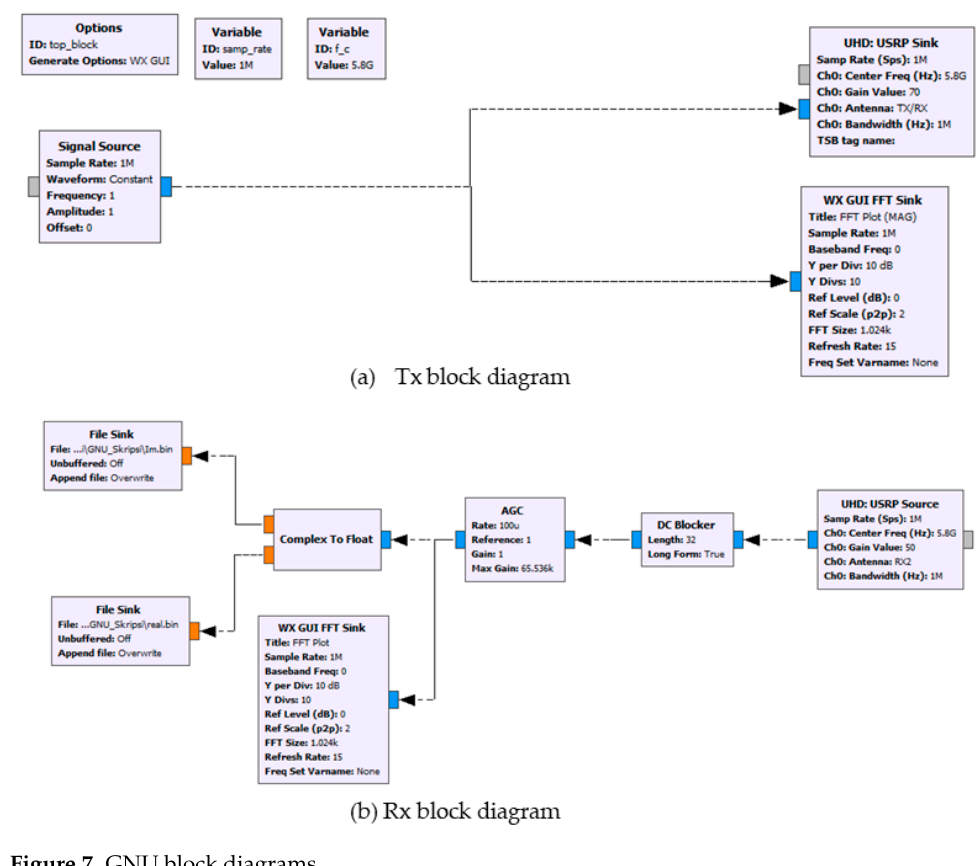
Figure 7. GNU block